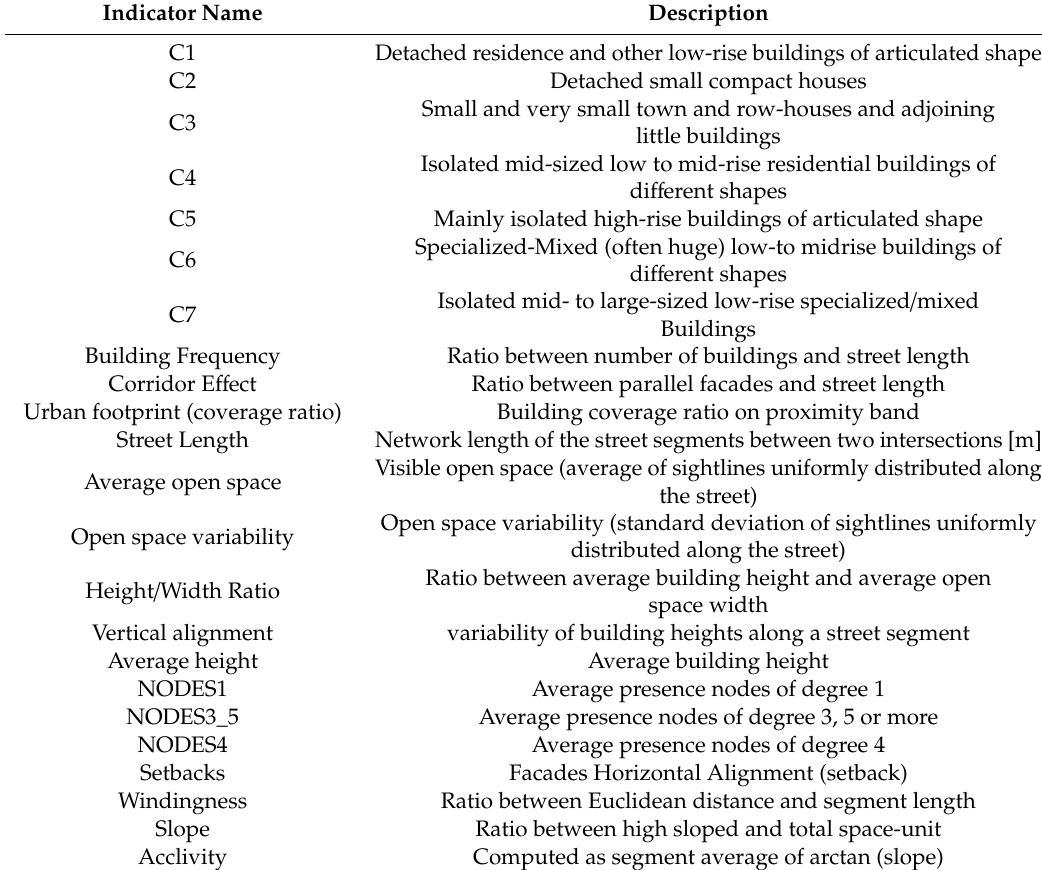
Table A2. List of Calculated Indicators for Multiple Fabric